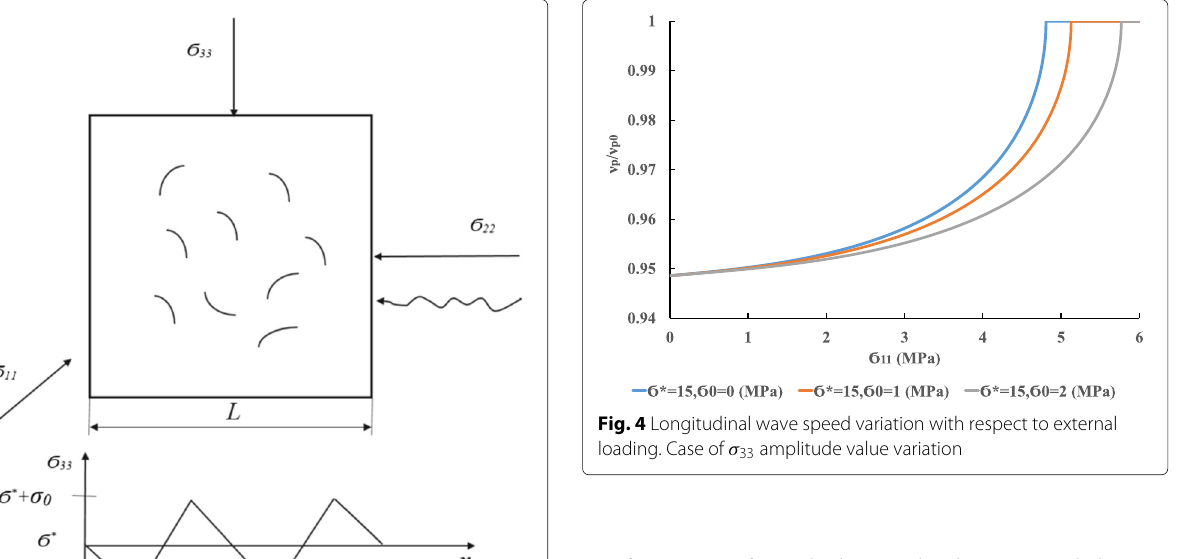
σ σ 0 of variation of 33 , the longitudinal wave speed changes only in quite narrow range of σ 11